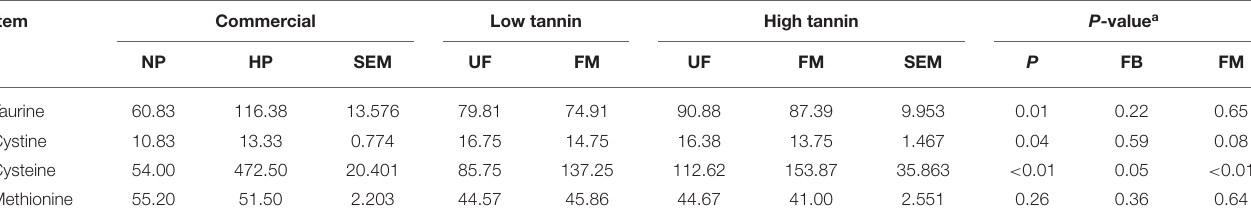
TABLE 7 | Plasma amino acid levels (nmol/ml) of dogs fed diets formulated with either low or high tannin fava beans without (UF) or with (FM) fermentation, or normal (NP) vs. high (HP) protein commercial diets for 7 days each * . Item